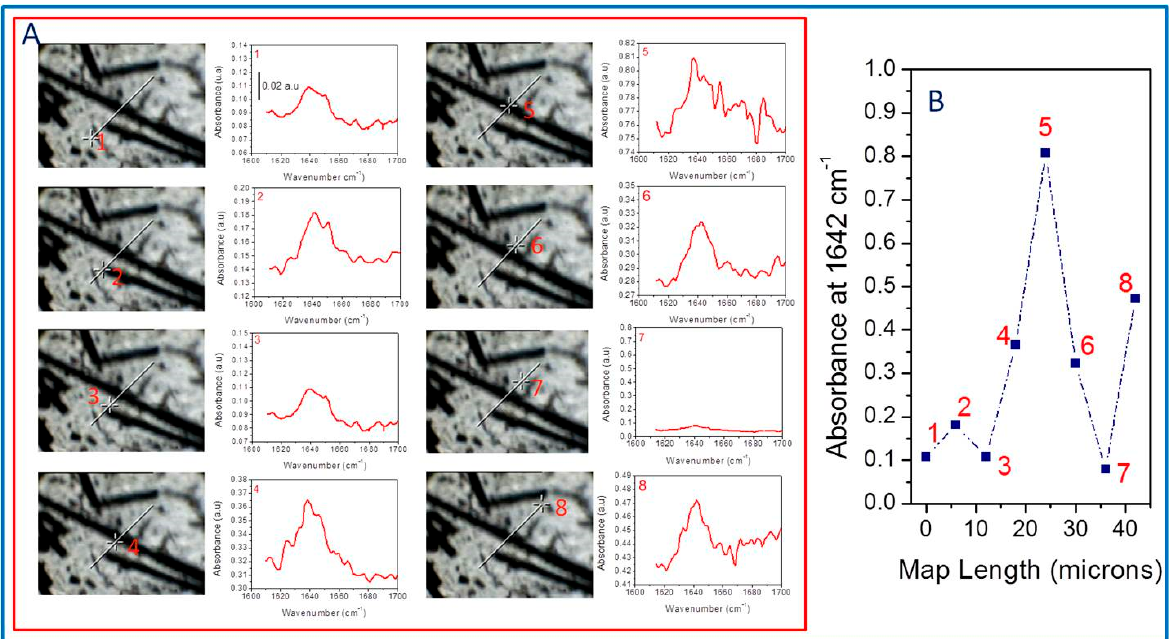
Figure 6. ( A ) SIRM images and spectra of the indicated samples obtained from S4 over-compressed specimens. ( B ) Evolution of the absorbance values for amido groups from SIRM image mapping.